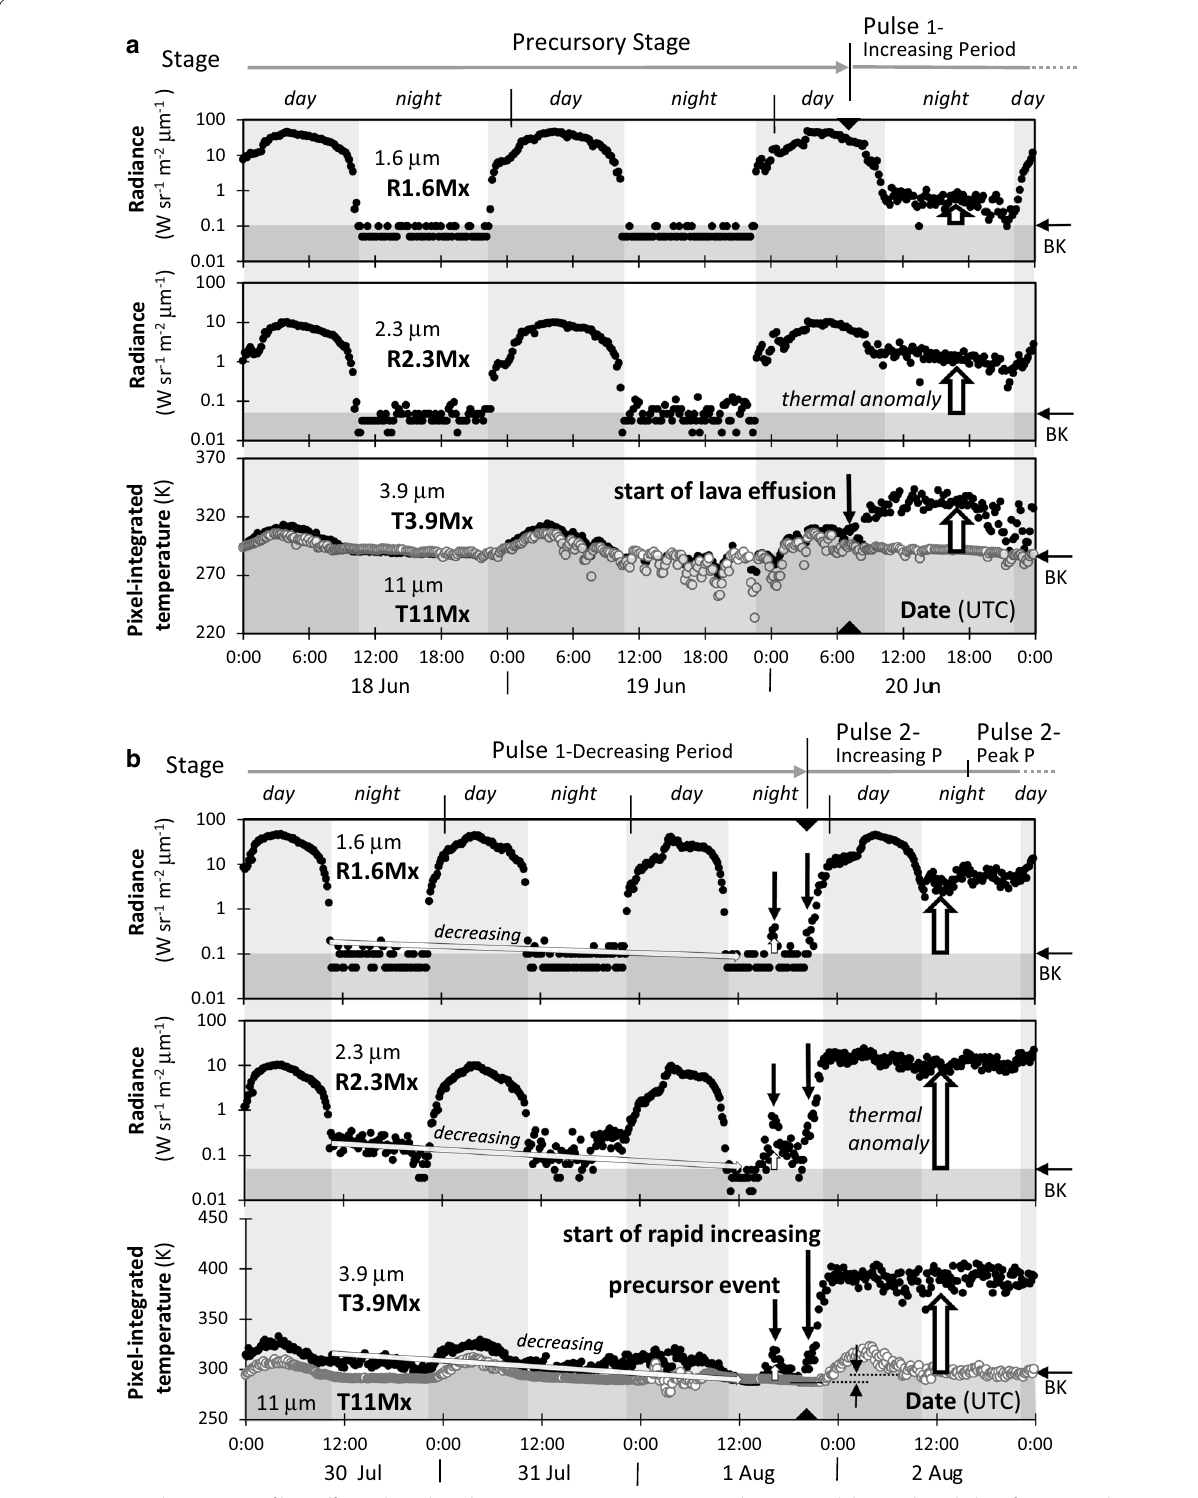
Fig. 5 a Estimated onset time of lava effusion based on short-term variations in R1.6Mx and R2.3Mx and the combined plot of T3.9Mx and T11Mx. Data were not corrected for sunlight effects. b Estimated time of the reactivation of lava